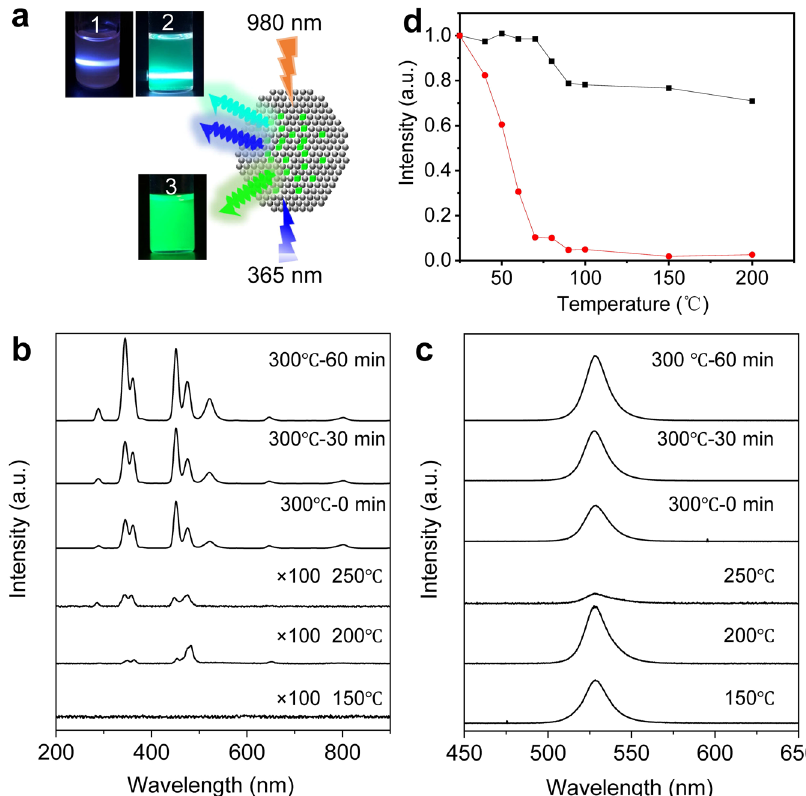
Fig. 3 Fluorescence of CsPbBr 3 – NaYF 4 :Yb,Tm hybrid nanocrystals. a Photographs showing different color fl uorescence emitted from